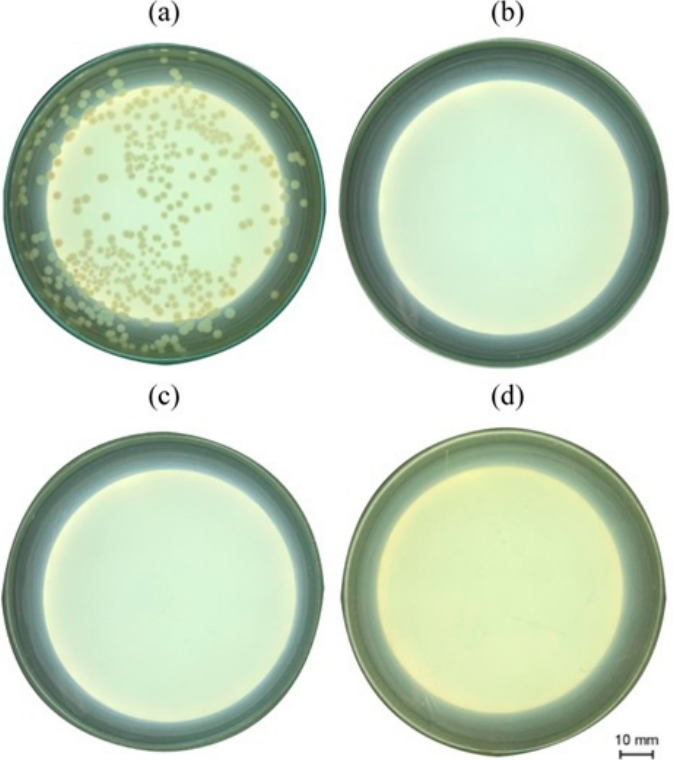
Figure 7. Evaluation of the bactericidal activity of chitosan pellets containing AgNPs against Esche- richia coli : ( a ) control; ( b ) 60 min of treatment; ( c ) 120 min of treatment; ( d ) 180 min of treatment.